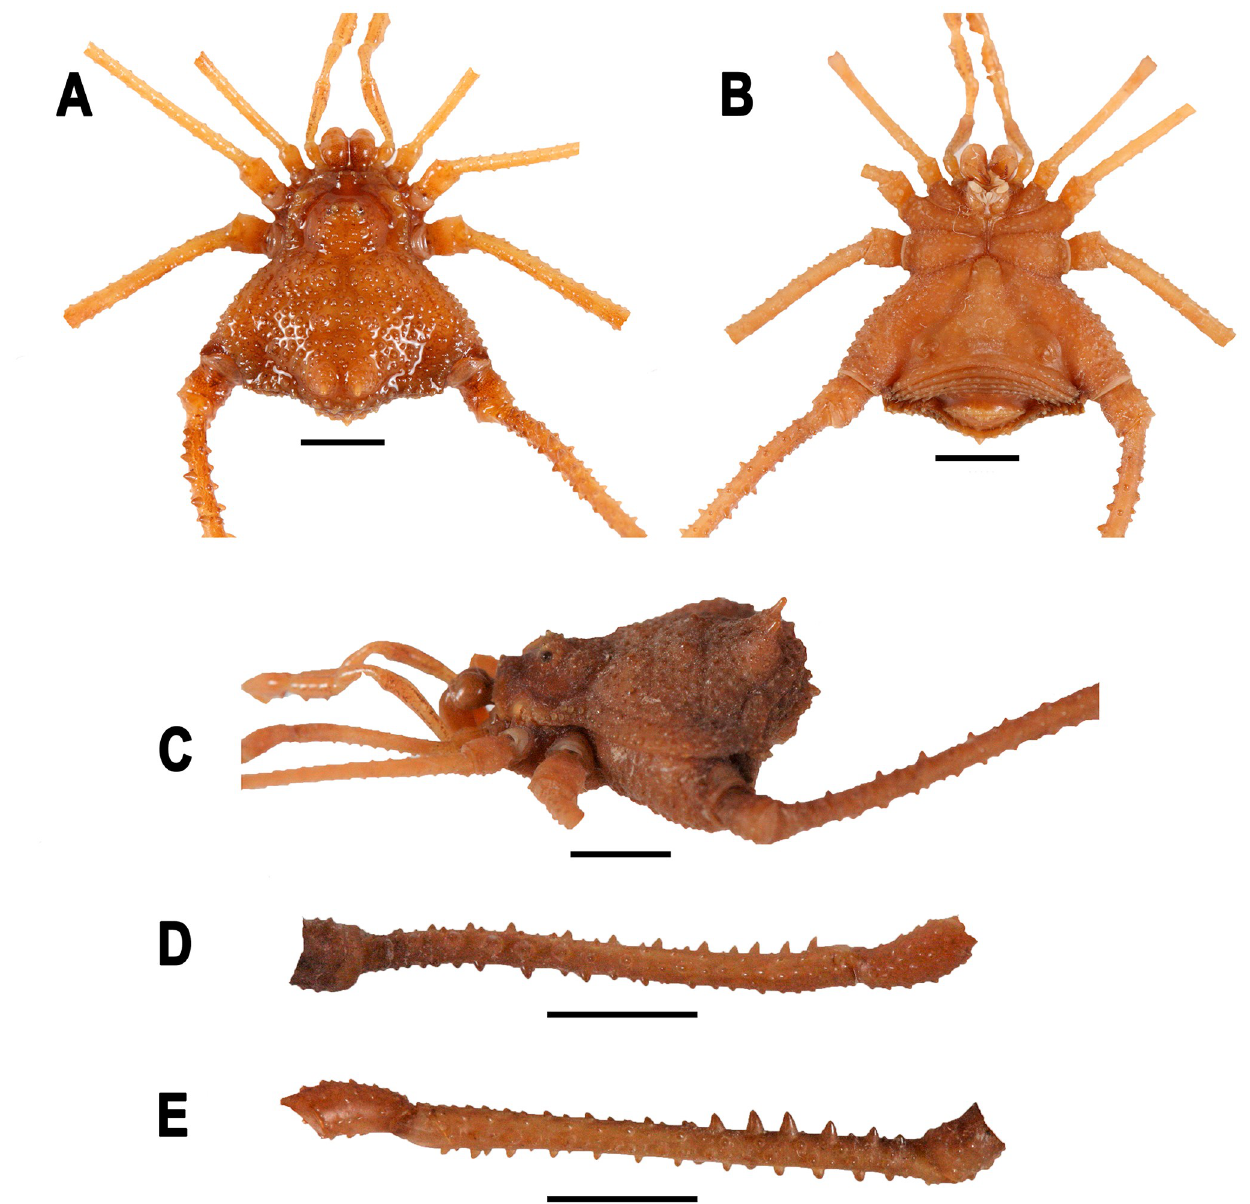
Fig 9. Neosadocus maximus ( “Bunoweyhia” minor female paralectotype, MNRJ 41806). A. Dorsal view. B. Ventral view. C. Left lateral view. D–E. Right trochanter–patella IV (D: retrodorsal view; E: retrolateral view). Scale bars: 3 mm. rounded ( N . bufo and N . maximus ) or conical ( N . robustus ) paremedian elevations on area III, both densely tuberculate; (iv) femur IV prolaterally curved (except in some N . robustus speci- mens with femur IV straight); (v) basal cluster of tubercles on femur IV; (vi) dorso-basal apophysis of femur IV with apex curved anteriorly, followed posteriorly by a row of long tubercles; (vii) and male genitalia with glans flattened and wrinkled, stylus elongated and curved, ventral process half the stylus length, and ventral plate subrectangular and with three pairs of macrosetae A, one pair of macrosetae B, three pairs of macrosetae C, one pair of macrosetae D and two pairs of macrosetae E. b. females: (i) outline of dorsal scutum γ -type;